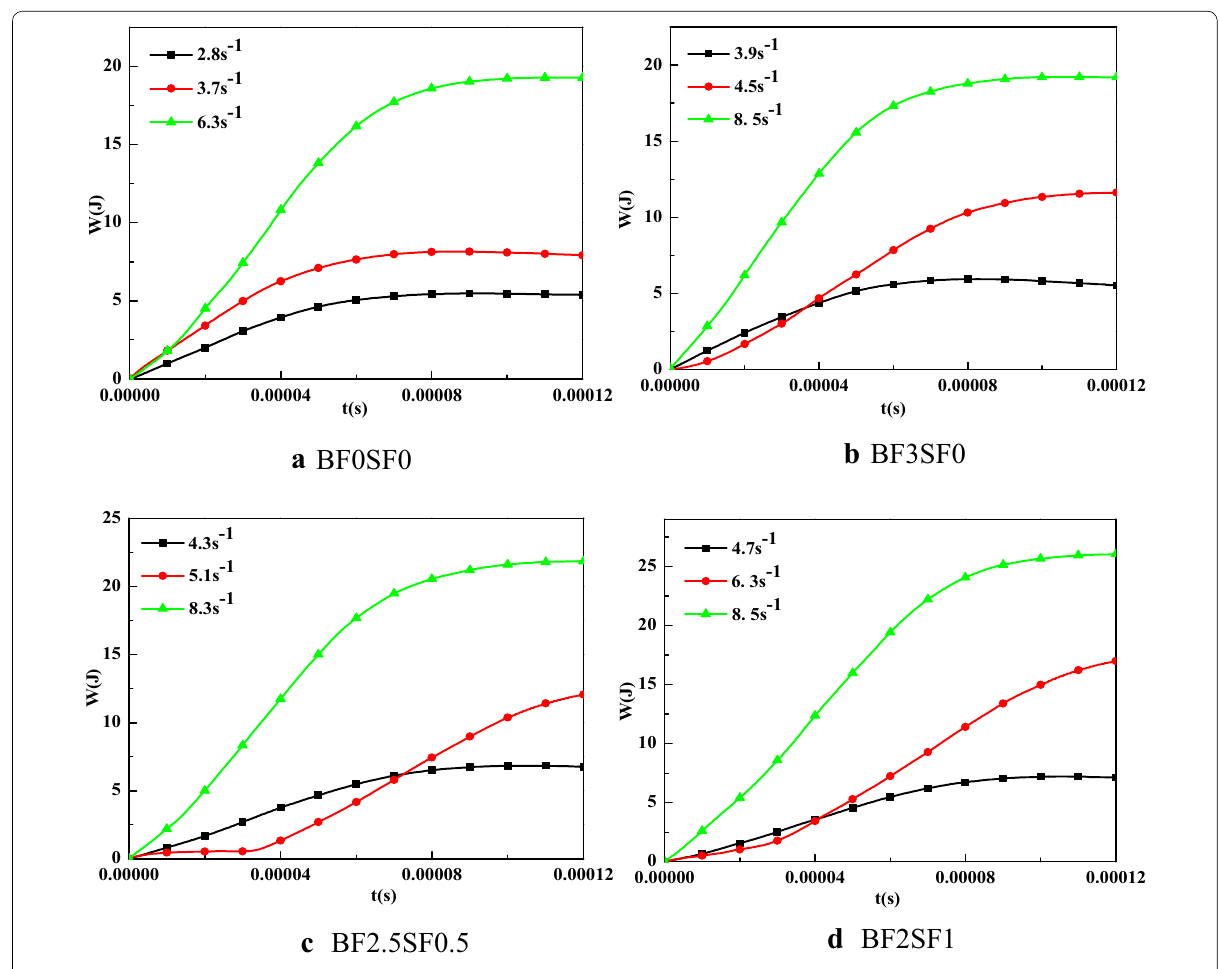
Fig. 12 Curves showing energy absorbed over time for various SHCC specimens.